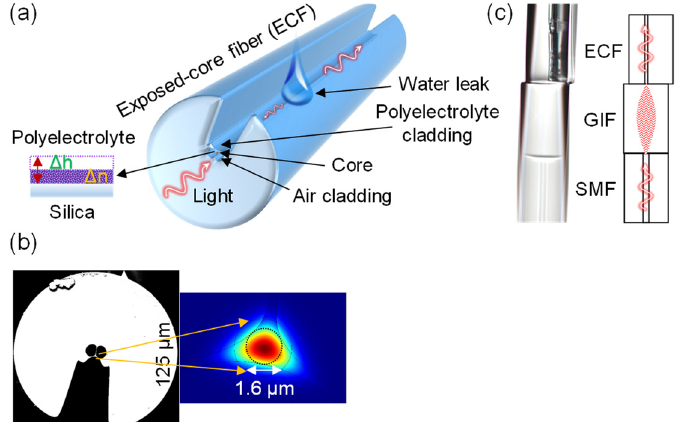
Figure 44. Distributed sensor. ( a ) Conceptual design of the sensing fiber. Inset: cross-section view of the polyelectrolyte coating. ( b ) Left: Scanning electron microscope image of the exposed-core fiber cross-section. Right: simulated mode profile in the core. ( c ) Splice sequence of the sensing fiber with an exposed-core fiber (ECF), a graded-index fiber (GIF), and a single-mode fiber (SMF). Reprinted with permission from ref. [227]. Copyright 2019 IEEE .